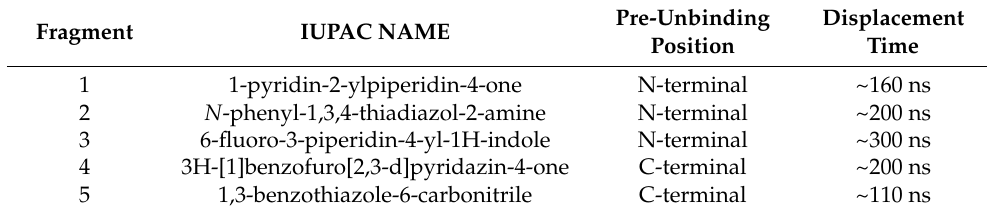
Table 1. Summary of the best five fragments after 500 ns of